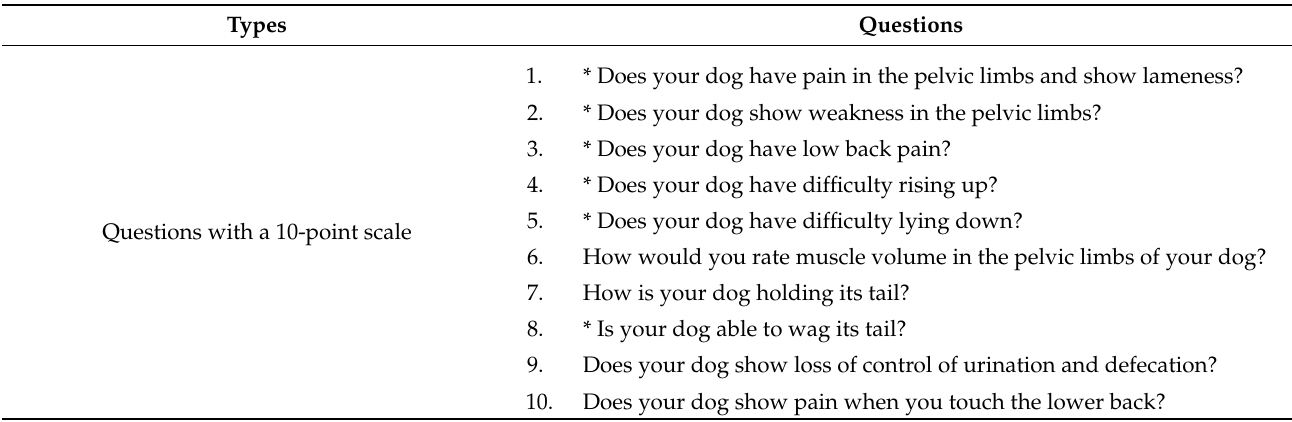
Table 1. Questionnaire to the owners of dogs with degenerative lumbosacral stenosis at baseline and 6, 12, and 24 weeks